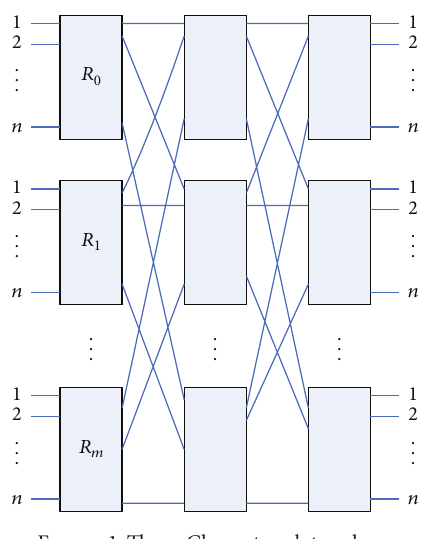
Figure 1: Three-Clos network